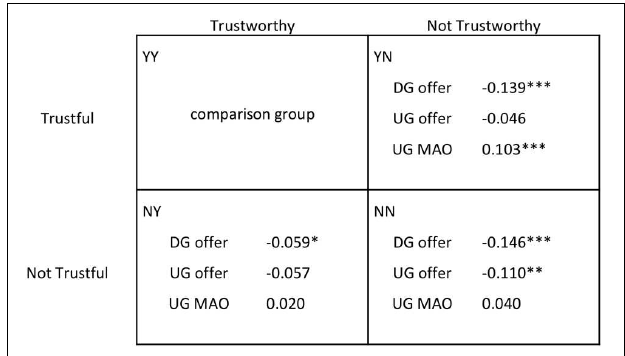
FIGURE 3 | TG outcomes as a function of DG and UG behavior. Multinomial logit output. A positive (negative) coefficient means that individuals with a higher (lower) value of that specific variable (i.e., DG offer, UG offer, or UG MAO) are more likely to be included in that specific group (i.e., YN, NY, or NN) compared to group YY. Controls are: gender, age, household income, educational level, cognitive skills, risk preferences, and order effects. Complete regressions comparing all groups as well as regressions without controls can be found in Appendix Table A2. ∗ p < 0.10 , ∗∗ p < 0.05 , ∗∗∗ p < 0.01.